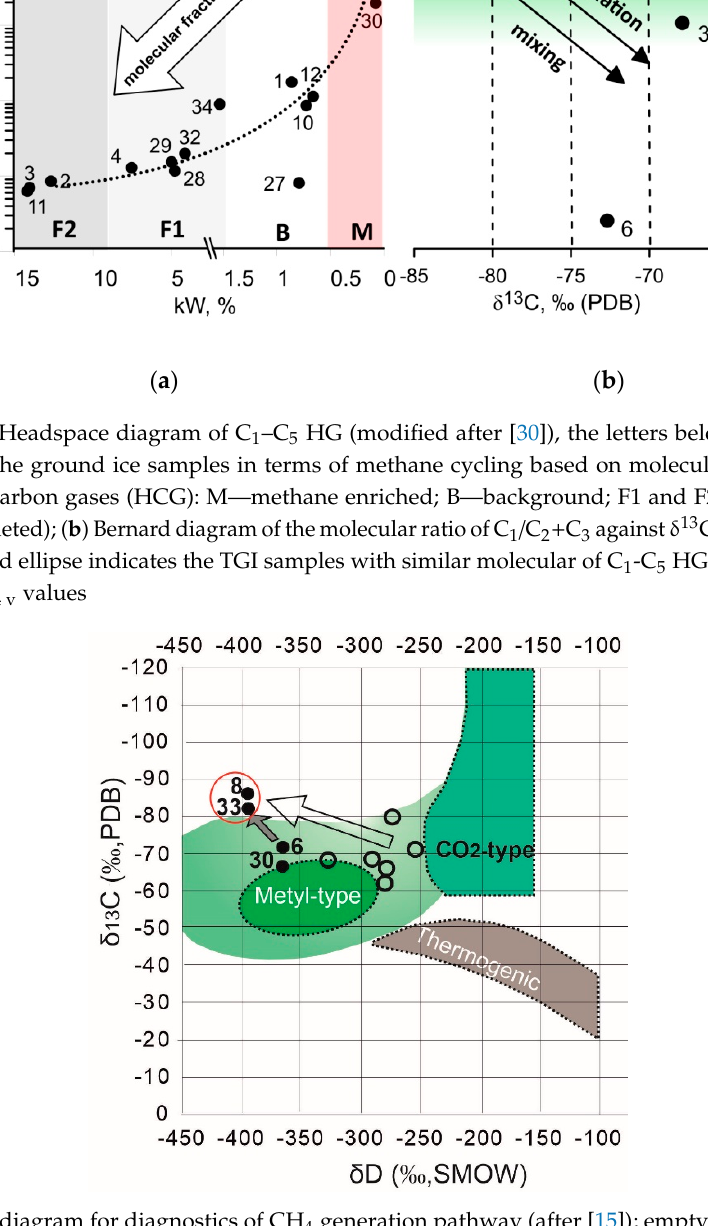
Figure 8. CD diagram for diagnostics of CH 4 generation pathway (after [15]); empty circles indicate the reference (published) data from Western Yamal nearshore permafrost landscapes [12]; the big transparent arrow marks the variation of CH 4 isotope signatures between the western Yamal (reference) and the Central Yamal (target) ground ice deposits; grey arrow points at variation of CH 4 isotope signatures between the methane-rich ground ice samples of the central Yamal thermocirque (target area). Red oval outline the TGI samples with anomalous methane content.